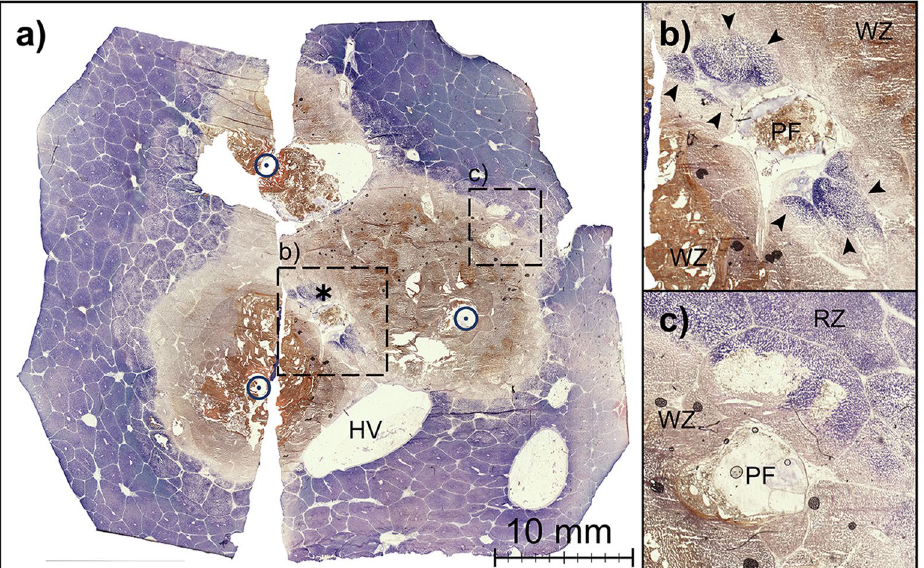
Figure 3. ( a ) Exemplary histological cross-section (NADH staining) of a confluent ablation (Perf15mm) with a partially vital hepatic vessel in the ablation center (asterisk). ( b ) Enlarged view of this vessel (portal field, 3.2 mm in diameter). Vital tissue (Right inverted triangle) as well as partially ablated tissue was observed adjacent to this portal field. ( c ) In contrast to the centrally located portal field, no vital tissue was seen around this portal field (3.0 mm in diameter) in the periphery of the ablation zone. (open circle = applicator puncture site; asterisk = ablation center; PF = portal field; HV = hepatic vein; WZ = white zone; RZ = red